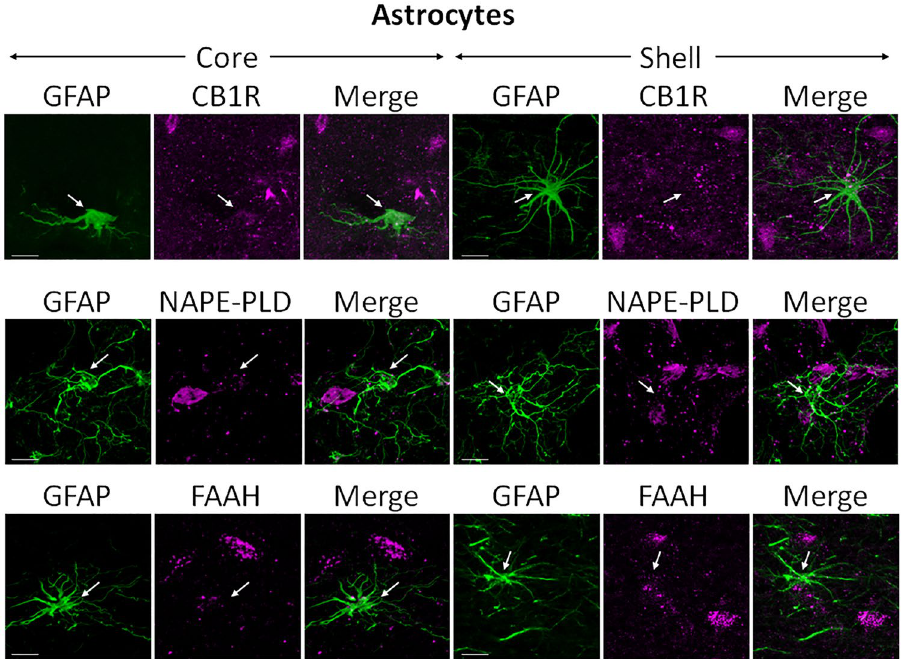
Figure 7. Double-label immunofluorescence illustrating co-localization of CB1R-IR, NAPE-PLD-IR, and FAAH-IR with glial fibrillary acidic protein (GFAP). Confocal micrographs of NAc co-immunolabeled for CB1R, NAPE-PLD, or FAAH (magenta), and GFAP (green), a specific marker for astrocytes, in core and shell. Arrows point at GFAP-positive glial cells that do not express either CB1R, NAPE-PLD, or FAAH. Scale bar = 10 µ